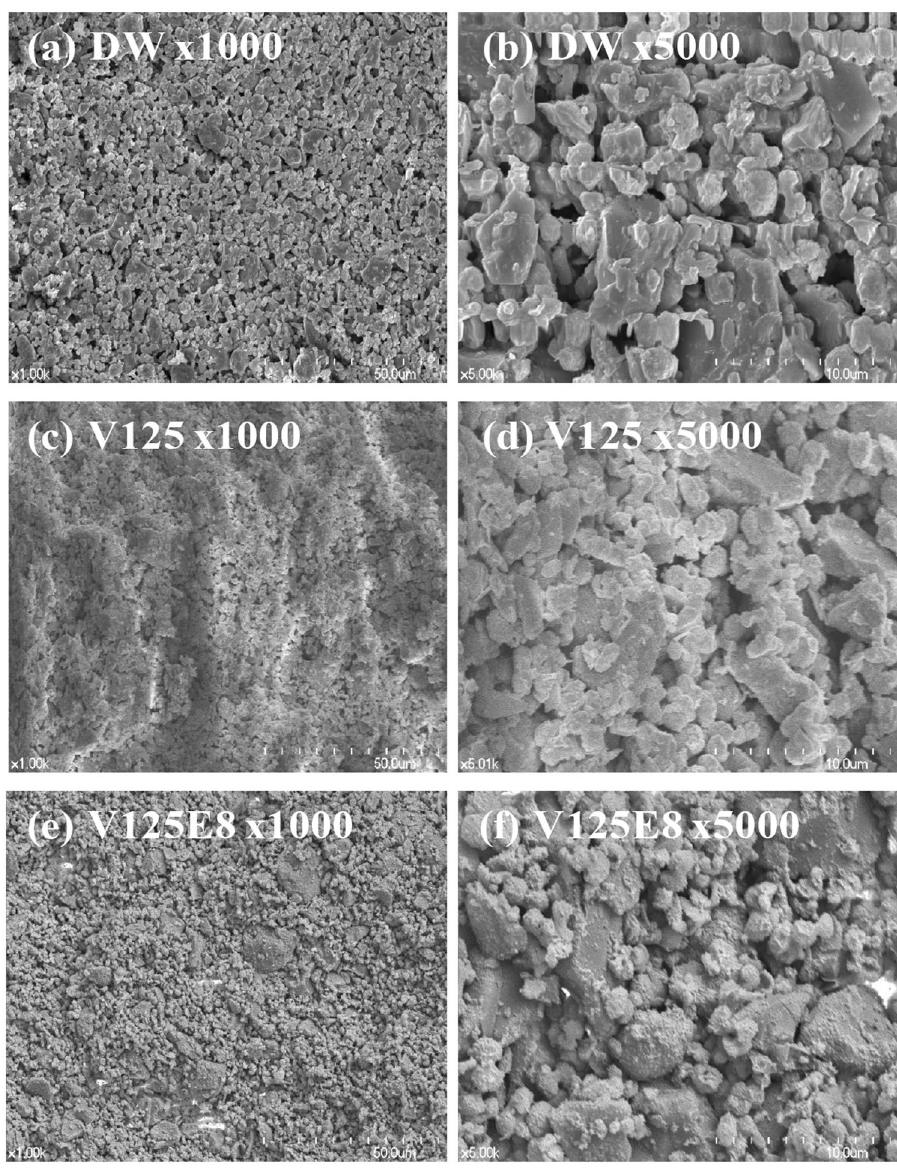
Figure 5. SEM images of the surface morphology of CPC composites. Larger pores 2–3 μ m in diameter are visible in the DW samples ( a , b ). The V125 and V125E8 samples seem denser compared to the DW samples, as they appear to have fewer pores ( c – f ). V125E8 appeared to have larger crystallites with less sharp edges than DW or V125, and to have a slightly denser surface than